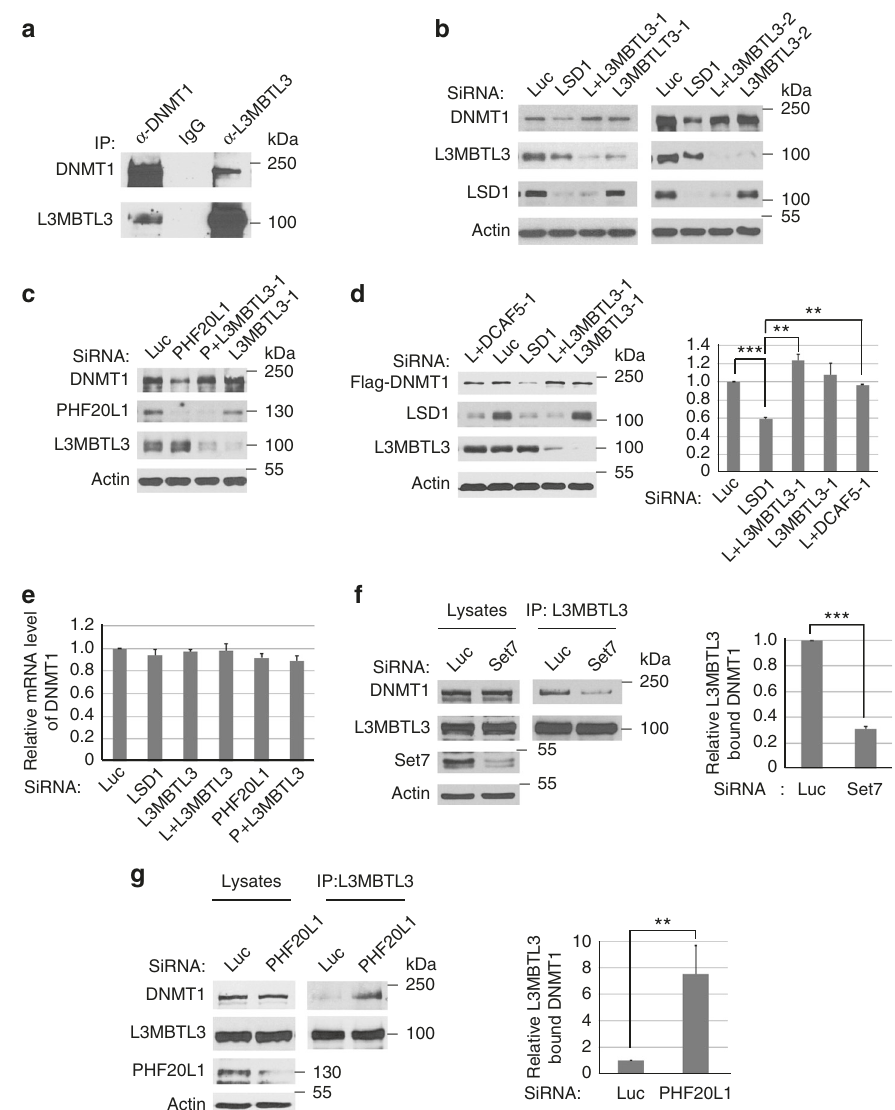
Fig. 4 L3MBTL3 regulates DNMT1 protein stability. a Interaction between DNMT1 and L3MBTL3. DNMT1 and L3MBTL3 were immunoprecipitated from HCT116 cells and western blotted with their respective antibodies. b Loss of L3MBTL3 stabilizes DNMT1 in LSD1 de fi cient cells. HCT116 cells were transfected with luciferase and two independent L3MBTL3 siRNAs in the presence or absence of LSD1 siRNA for 48 h. Proteins were analyzed by indicated antibodies. c Downregulation of L3MBTL3 prevents DNMT1 degradation in PHF20L1 knockdown cells. Experiments were conducted as in Fig. 4b except PHF20L1 siRNA is used. d Loss of DCAF5 or L3MBTL3 stabilizes Flag-DNMT1 in LSD1 de fi cient cells. The Flag-DNMT1 in pMSCV-Puro was stably expressed in 293 cells and its protein stability was analyzed after transfecting either L3MBTL3 or DCAF5 siRNAs, together with or without LSD1 siRNA as in Fig. 2a, using Student ’ s t-test for signi fi cant differences. ** P < 0.01 and *** P < 0.001. e Loss of L3MBTL3 does not signi fi cantly affect DNMT1 mRNA levels. The DNMT1 mRNA levels were measured in triplicated samples in cells treated with siRNAs for Luciferase, LSD1, PHF20L1, L3MBTL3, LSD1 + L3MBTL3, and PHF20L1 + L3MBTL3 by RT – qPCR. The quanti fi cations are represented by bar graph with mean and standard deviation (S.D.) for error bars from three replicate samples and normalized to luciferase siRNA control. f Downregulation of SET7 reduces the interaction between DNMT1 and L3MBTL3. HCT116 cells were transfected with control and SET7 siRNAs and the interaction between DNMT1 and L3MBTL3 was analyzed by immunoprecipitation